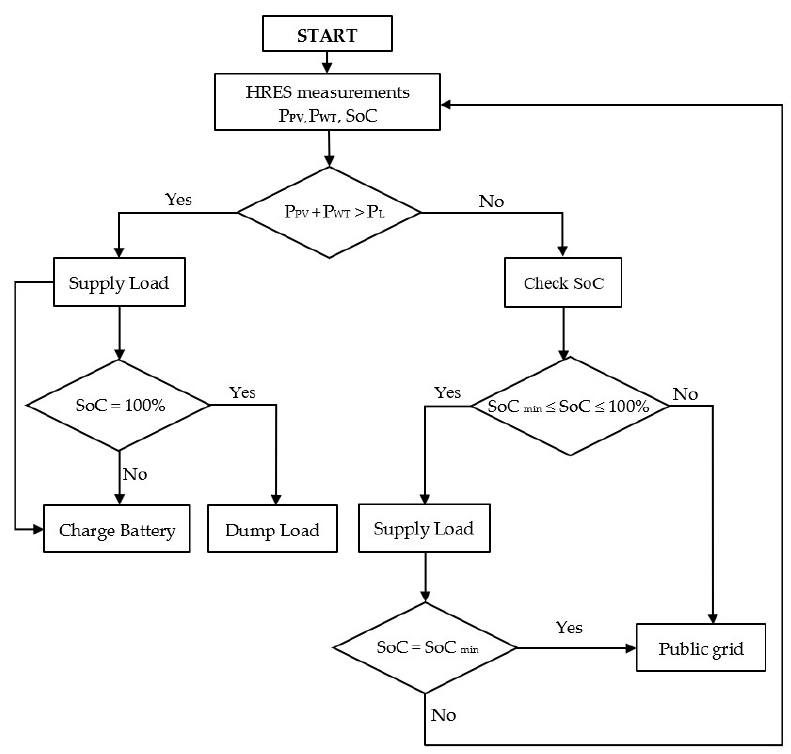
Figure 7. Operational flowchart for hybrid renewable energy system [28].